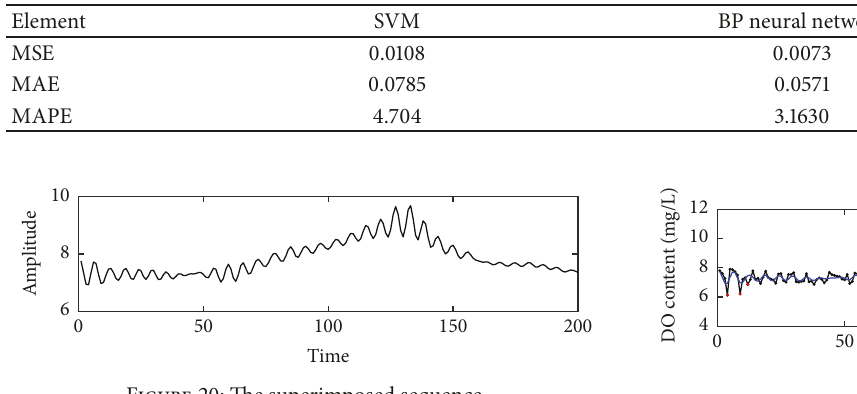
Figure 20: The superimposed sequence.